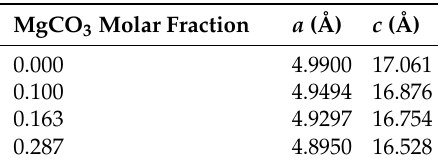
Table 1. Crystallographic cell parameters of Goldsmith et al. [23] and Zhang et al. [38] for calcite with variable Mg contents used to constrain the refinement of magnesian